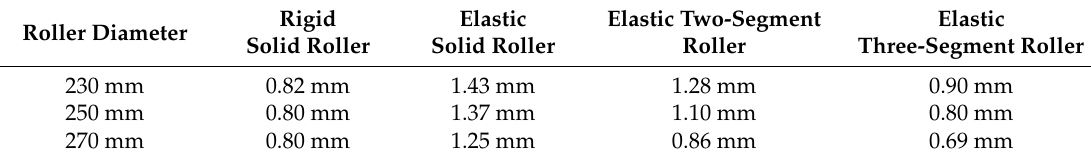
Table 7. Bulge deformation on the wide side with different roller